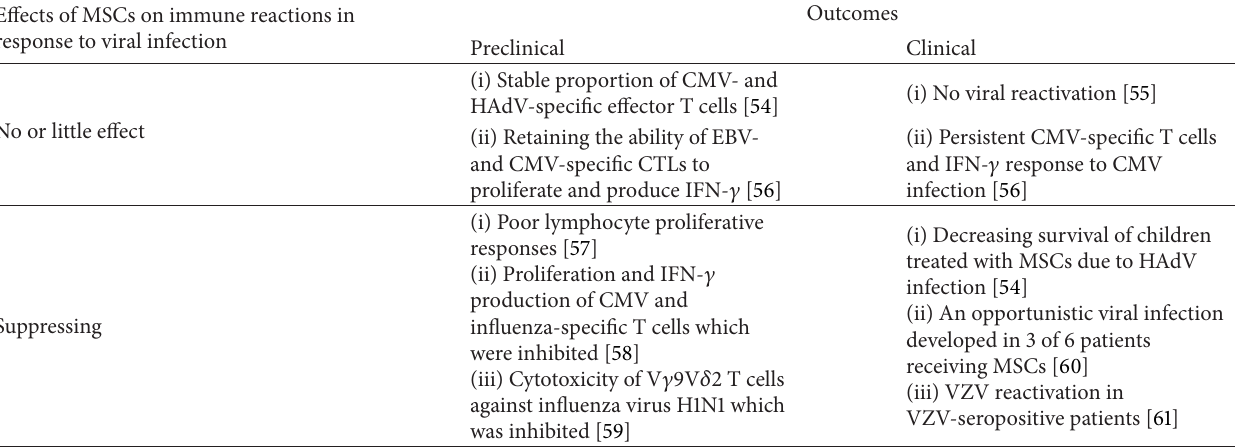
Table 1: Differential effects of MSCs on immune response against viral infection or infectious agents. Effects of MSCs on immune reactions